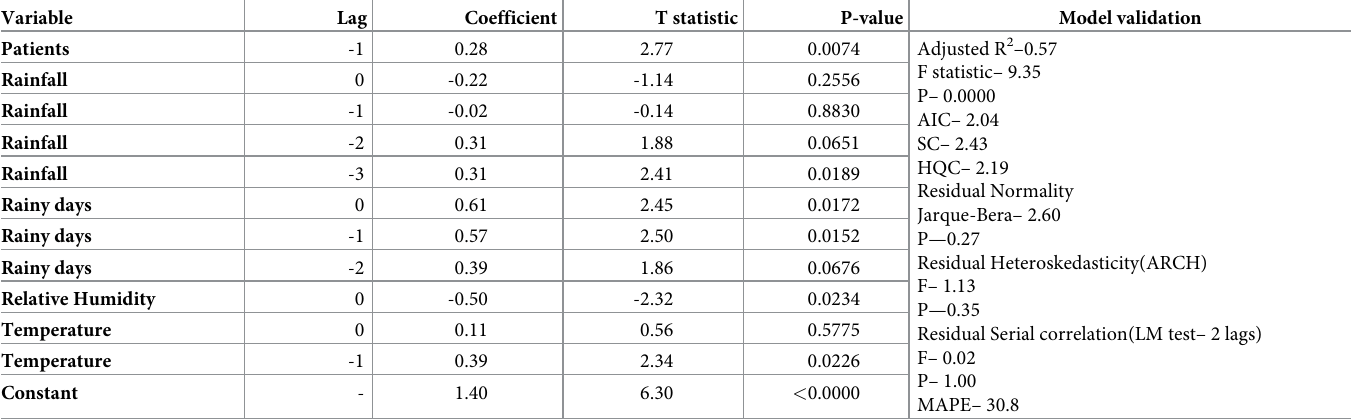
Table 6. Model description of the best model